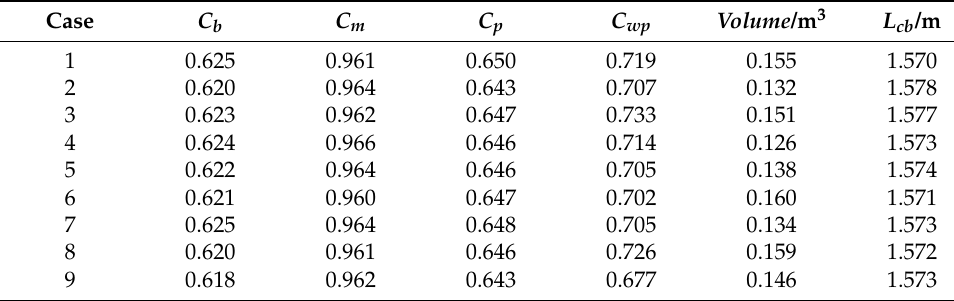
Table 5. The hydrostatic data corresponding to each case.